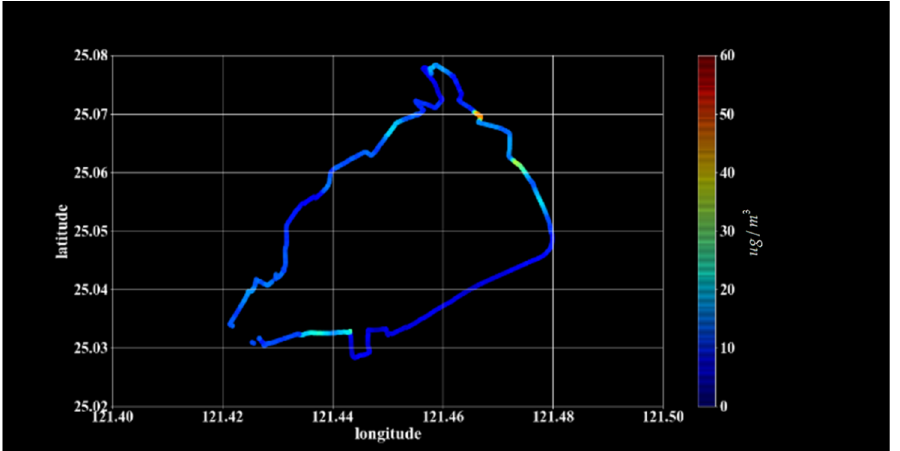
Figure 8. Mobile sensing data at 10:00 A.M. on 3 January 2019.